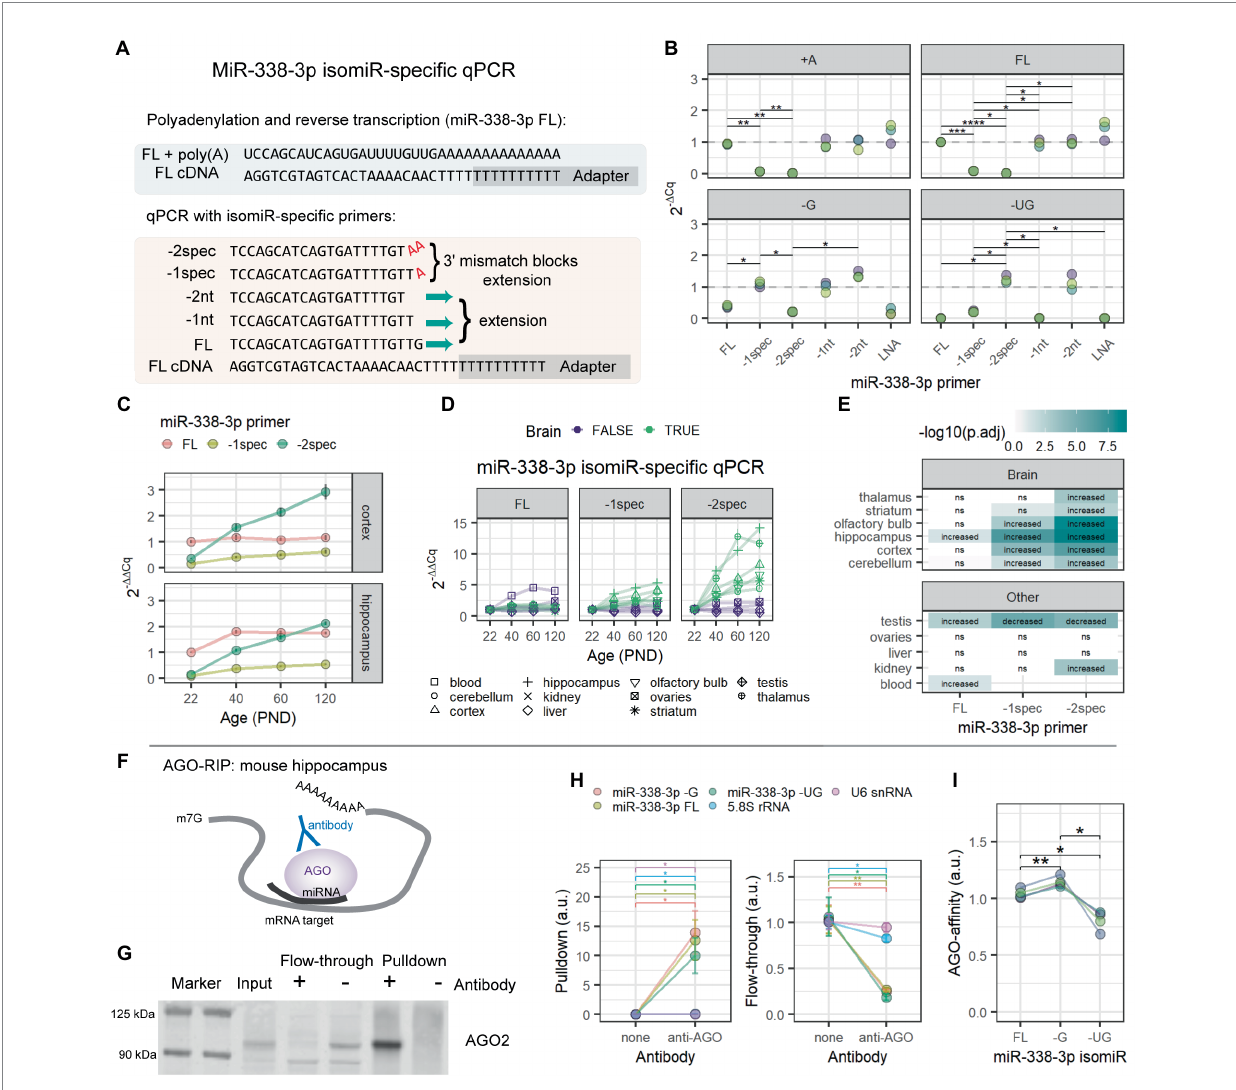
FIGURE 2 MiR-338-3p 3 ′ trimmed isomiRs increase with age and associate with AGO proteins in mouse hippocampus. (A) Overview of isomiR-specific RT-qPCR assays for miR-338-3p. MiRNAs are first poly(A)-tailed. Reverse transcription is performed with a poly(T) primer containing a universal adapter sequence. RT-qPCR is then performed with a forward primer targeting the isomiR of interest and a universal reverse primer matching the adapter sequence. As shown, the miR-338-3p FL primer fully anneals to cDNA made from the FL isomiR. However, − G and − UG isomiRs are excluded due to mismatches at the 3 ′ end of primer binding, which prevents efficient RT-qPCR amplification. However, the -1spec and -2spec primers fully anneal to the − G and − UG isomiRs, respectively, while excluding longer forms by adding terminal A nucleotides to each primer that match the poly(A) tail added prior to reverse transcription. (B) MiR-338-3p isomiR detection by 3 ′ isomiR-specific RT-qPCR assays. RNA oligomers were commercially synthesized and used as templates for the assays shown in (A) . All Cq values were normalized to the mean Cq value for miR-338-3p FL isomiR detection by the miR-338-3p FL primer. N = 3. Two-way ANOVA: p(isomiR) = 4.96e-04, p(primer) = 2.69e-05, p(interactive) = 9.54e-21. Holm-adjusted p -values for pairwise comparisons: * p < 0.05, ** p < 0.01, *** p < 0.001, **** p < 0.0001. (C) MiR-338-3p 3 ′ trimmed isomiRs increased between P22 and P120. IsomiRs were detected by isomiR-specific RT-qPCR assay described in (A) . All Cq values were normalized within tissue to the mean Cq value for miR-338-3p FL isomiR detection by the miR-338-3p FL primer. (D) Increases in miR-338-3p 3 ′ trimmed isomiRs between P22 and P120 might be brain-specific. The -UG isomiR increases with age in all brain tissues observed, but not in non-brain tissues, other than a small increase in kidney. Similarly, the -G isomiR increases with age in most brain tissues, except thalamus and striatum, but none of the non-brain tissues. (E) Statistical results for data in (D) . Data were analyzed by linear regression modeling within each tissue: isomiR ~ Age + Sex. P -values were adjusted for multiple comparisons using the FDR method. “Increased”: p(Age) < 0.05 & Estimate (Age) > 0. “Decreased”: p(Age) < 0.05 and Estimate (Age) < 0. “ns”: p > 0.05. (F) Overview of AGO-RIP experiments in (G–I) . AGO-miRNA-mRNA target complexes were pulled down with an AGO-specific antibody. (G) Western blot validation of AGO-IP protein fractions. AGO2 was depleted in the flow-through and enriched in the pulldown fraction when an AGO-specific antibody was used for IP. In the bead only (no AGO antibody) condition, AGO2 was not detectable in the pulldown fraction and remained in the flow-through. (H) qPCR detection of RNA in pulldown (left) and flow-through fractions (right) from AGO-RIP experiments in mouse hippocampus. MiR-338-3p FL, − G, and − UG isomiRs associate with AGO proteins with high affinity and were significantly depleted in flow-through. Significant, but lower-affinity, associations were also observed between AGO and 5.8S rRNA and U6 snRNA. N = 4 biological replicates. Two-way ANOVA (pulldown): p(RNA) = 0.000247, p(antibody) = 0.036000, p(interactive) = 0.000249. Two-way ANOVA (flow-through): p(RNA) = 1.00e-03, p(antibody) = 8.00e-03, p(interactive) = 3.98e-05. Holm adjusted p -values for pairwise comparisons: * p < 0.05, ** p < 0.01. (I) Relative AGO affinities of the miR-338-3p FL, − G, and − UG as detected by RT-qPCR from the pulldown fraction of AGO-IPs shown in (H) . The − G isomiR appears to have a slightly higher affinity than the other isomiRs, whereas the − UG isomiR has the lowest affinity. One-way repeated measures ANOVA: p = 0.018. Holm adjusted p -values for pairwise comparisons: * p < 0.05, ** p < 0.01. See Supplementary Figure S3 for functional assays examining miR-338-3p isomiR mimics in Neuro-2a